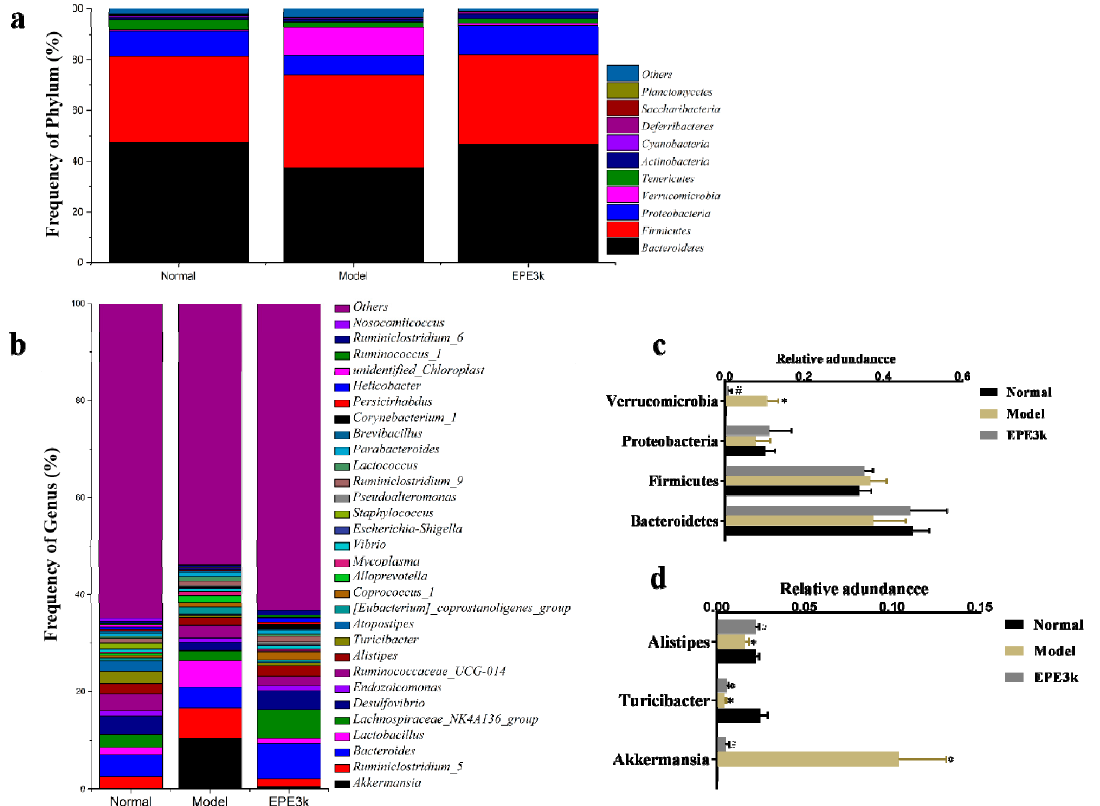
Figure 4. Effects of EPE3k treatment on the relative abundances of intestinal microflora at phyla ( a ) and genus ( b ) levels. The largest phyla ( c ) and genus ( d ) levels changes in microbiota were shown in different groups. * p < 0.05: compared with normal group; # p < 0.05: compared with model group.